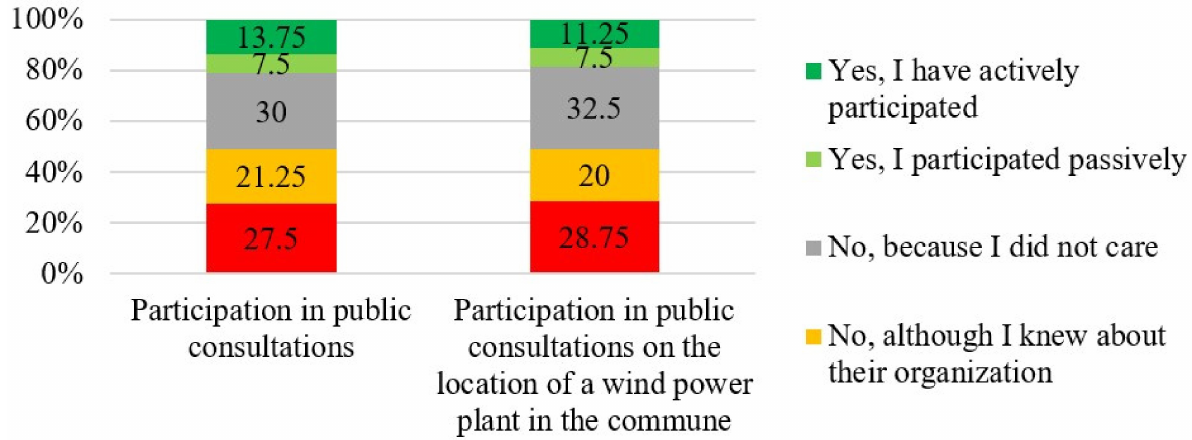
Figure 5. Participation in social consultations in general and in the case of the siting of a wind farm in the municipality of one’s residence (%). Source: based on own research.